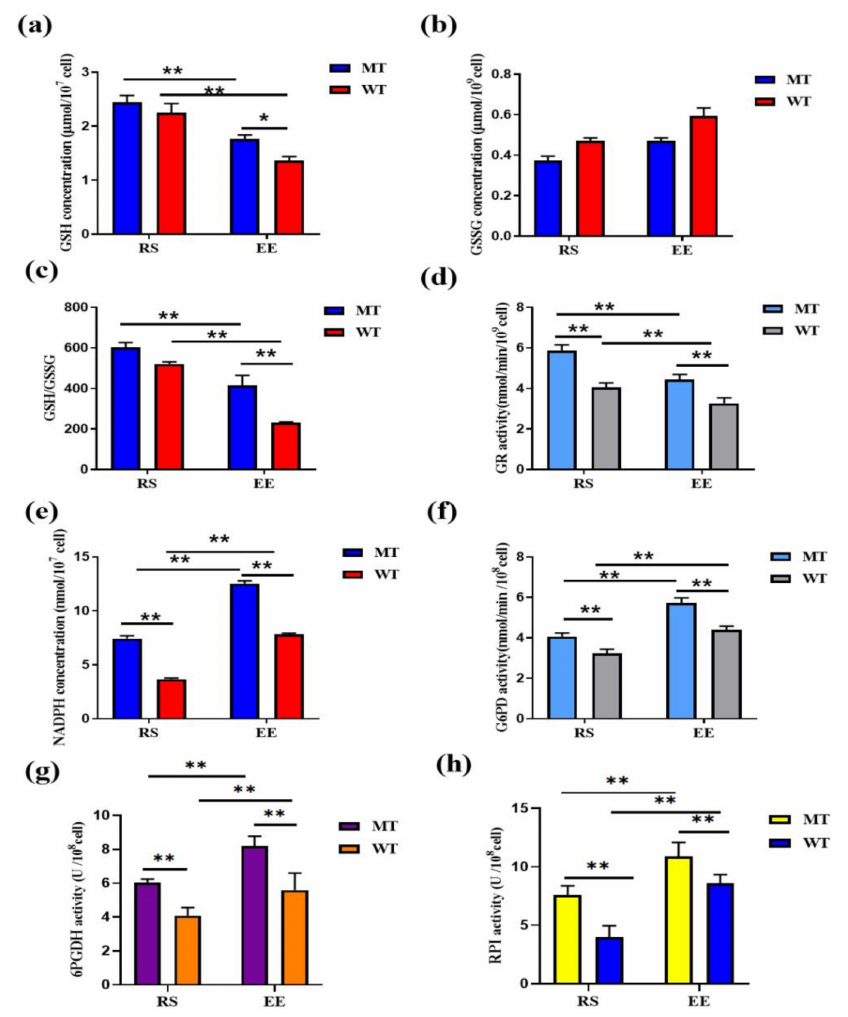
Figure 5. MSTN knockout increases erythrocyte antioxidant capacity via GSH. ( a ) Concentration of GSH; ( b ) Concentration of GSSG; ( c ) Ratio of GSH/GSSG; ( d ) Activity of GR; ( e ) Concentration